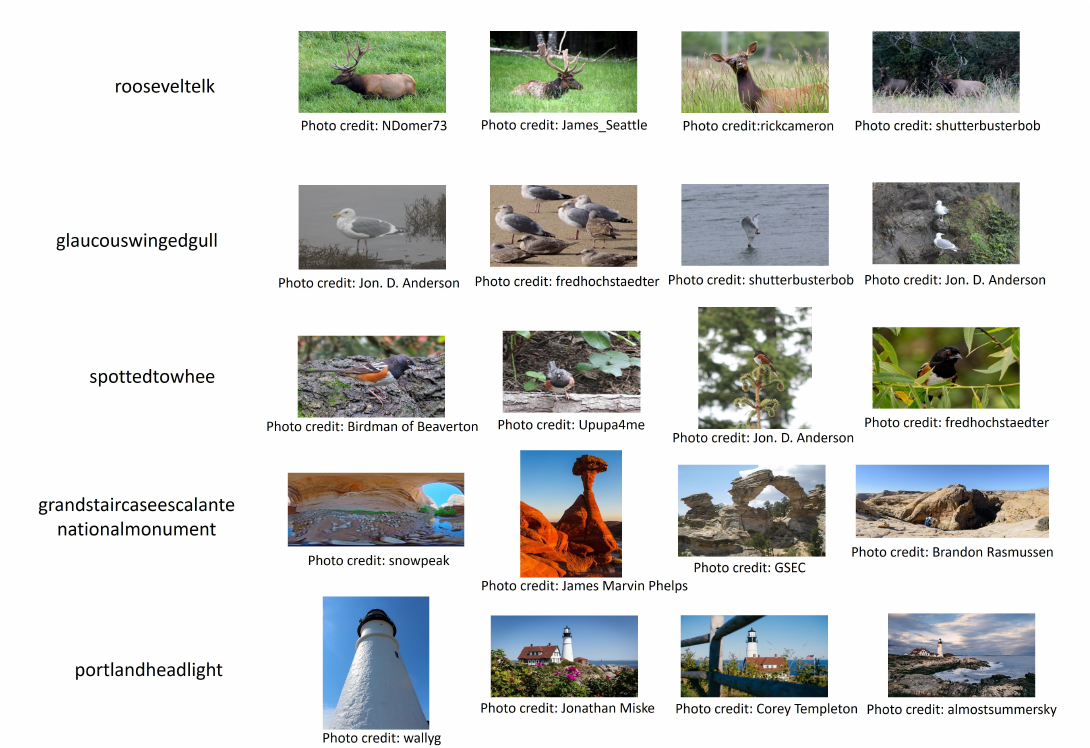
Figure 15. Examples of geospatial concepts whose test images were all correctly recognized.